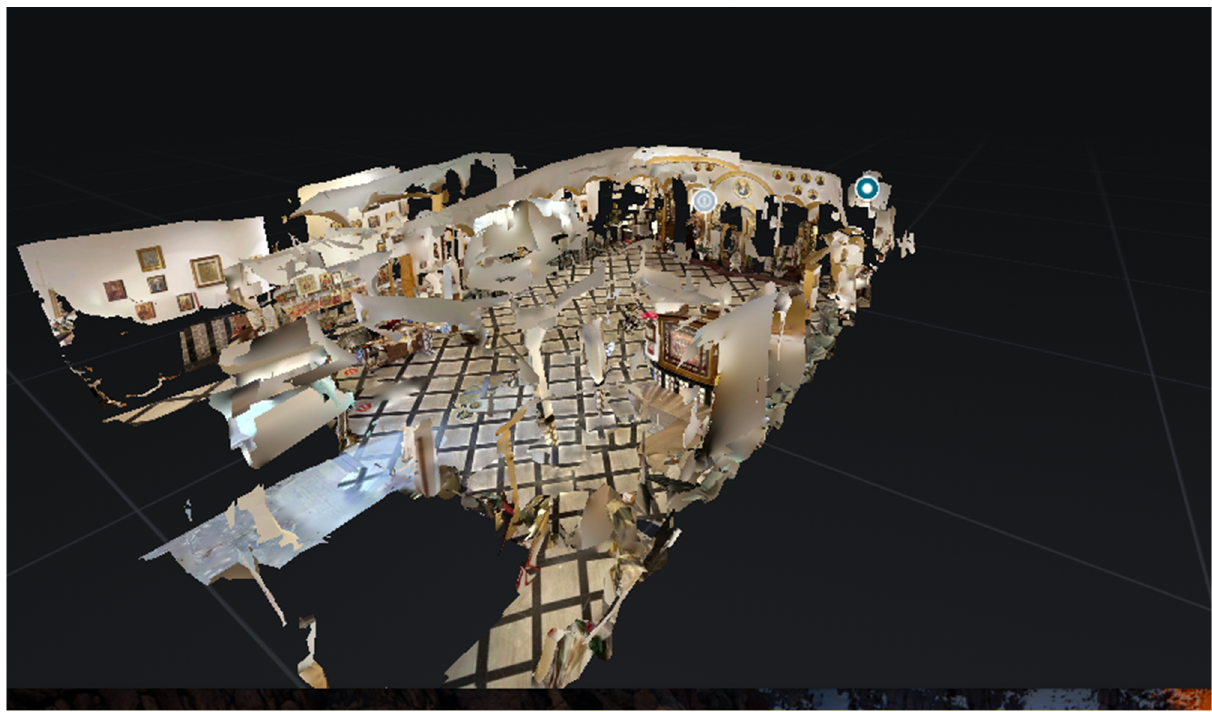
Figure 8. A 3D model of the church space looking towards the